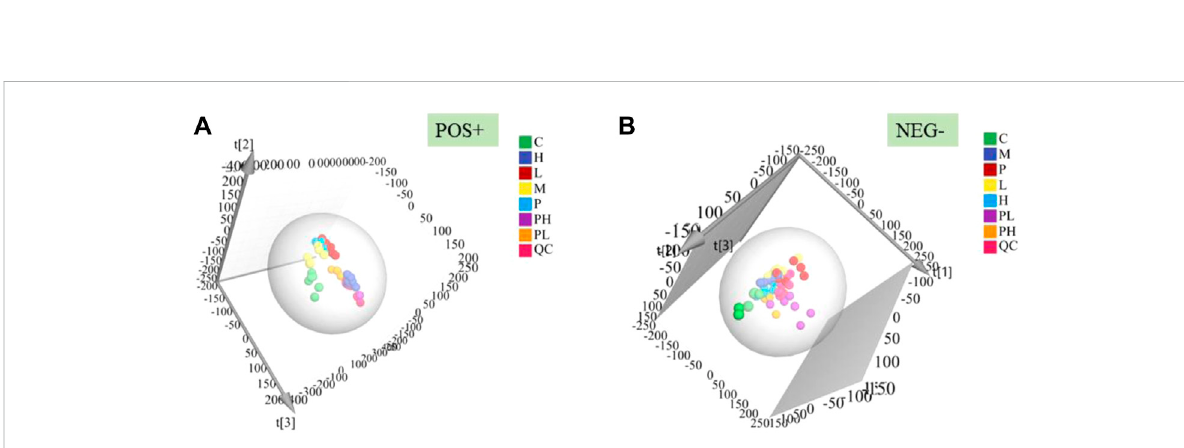
FIGURE 4 PCA score plots in positive (A) and negative (B) ion mode of serum samples among control [C], model [M], cisplatin [P], GYP low-dose [L], GYP high-dose [H], cisplatin + low-dose GYP [PL], cisplatin + high-dose GYP [pH] group and QC group